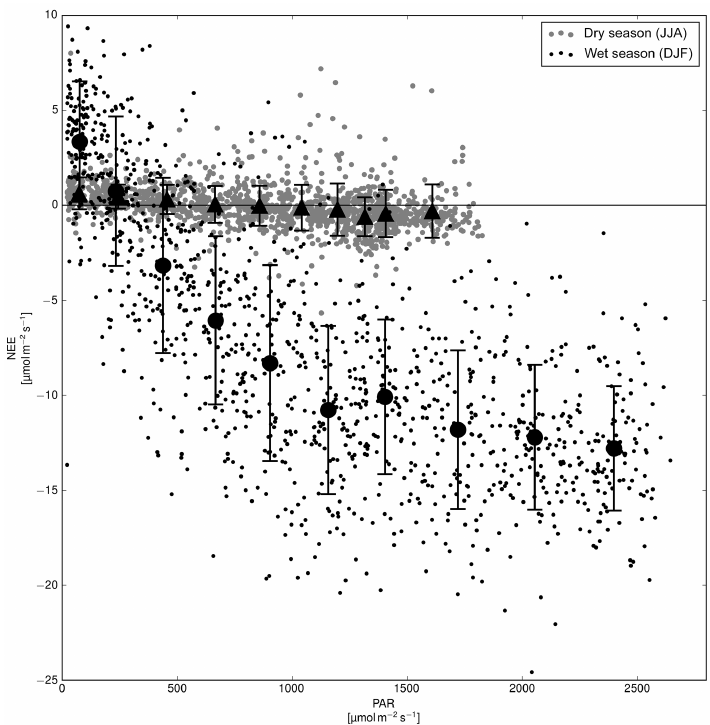
Figure 3. Relationship between PAR and daytime NEE for the wet (DJF) and dry (JJA) seasons from September 2010 to August 2011. The triangles (dry season) and circles (wet season) indicate bin averaged values and error bars indicate ± 1 standard deviation. Daytime was defined as periods when PAR is higher than 20µmolm − 2 s − 1 . Each bin in the dry season contained 157 values, whereas the wet season bins contained 125